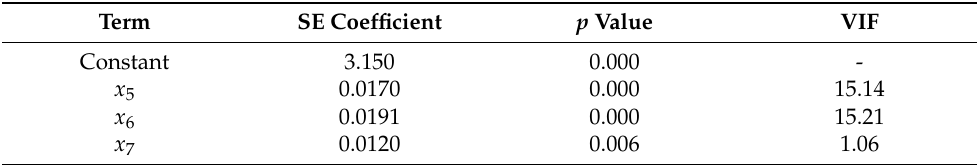
Table 5. Coefficient analysis of expulsion occurrence prediction model.